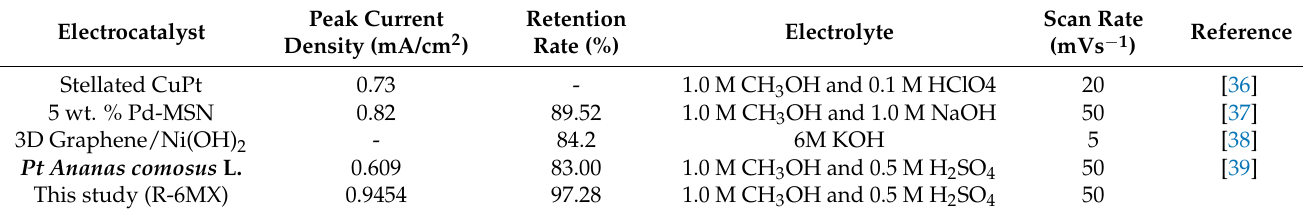
Table 3. Electrochemical performance comparison between several electrocatalysts to